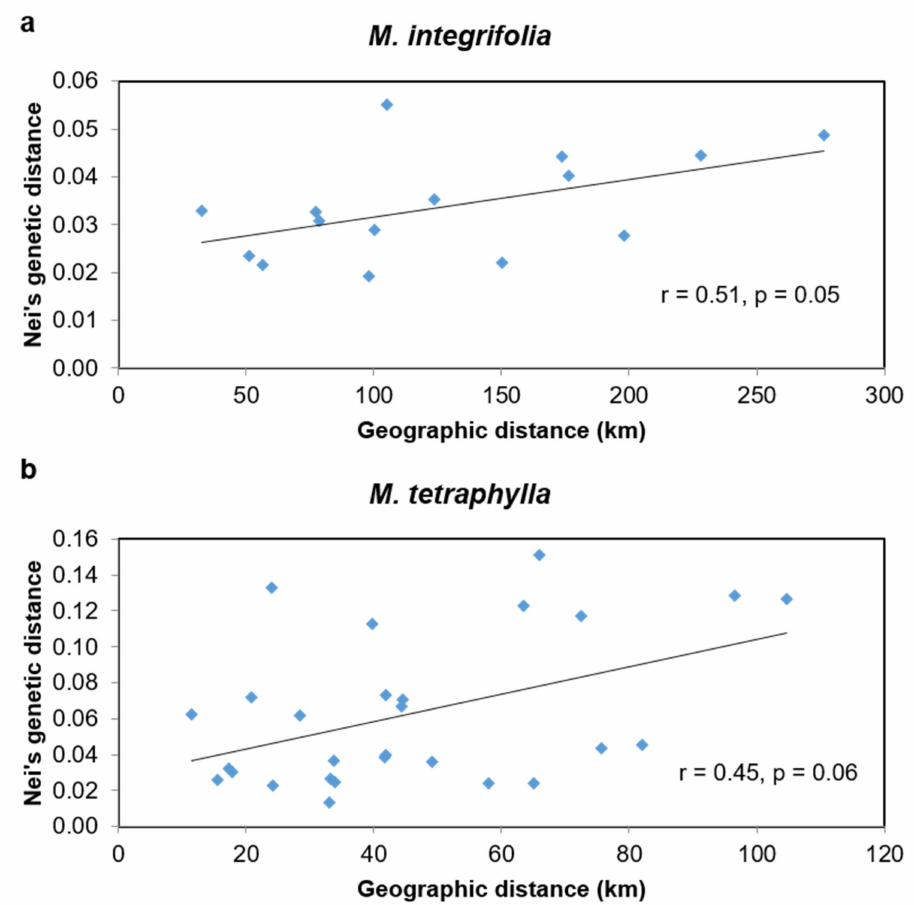
Figure 5. Correlation between genetic and geographical distance among ( a ) six localities of M. integrifolia , and ( b ) eight localities of M. tetraphylla , based on a Mantel test at 999 random